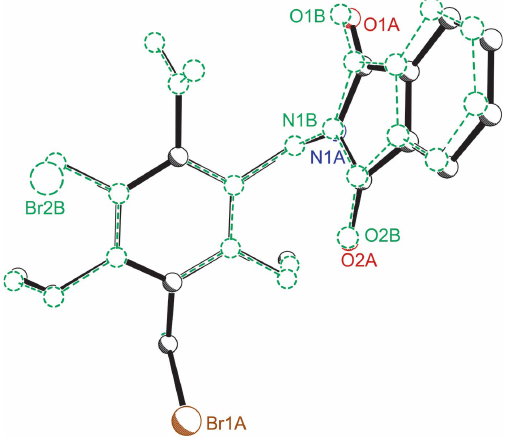
Figure 2 Least-squares overlay of 1-A and 1-B with an r.m.s. deviation of 0.0089 A ˚ . The hydrogen atoms are omitted for